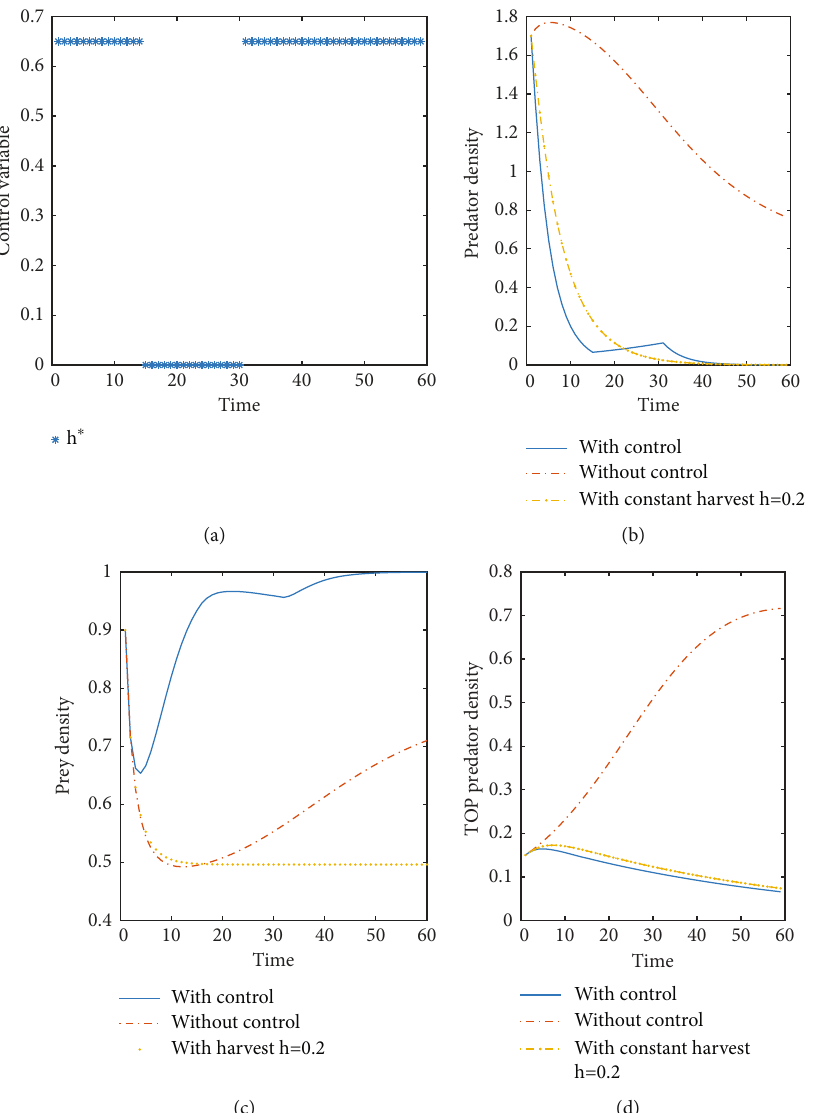
Figure 4: (a) The optimal control variable as a function of time. (b) The e ff ect of optimal harvesting on the predator species. (c) The e ff ect of optimal harvesting on the prey species. (d) The e ff ect of optimal harvesting on the top predator species.